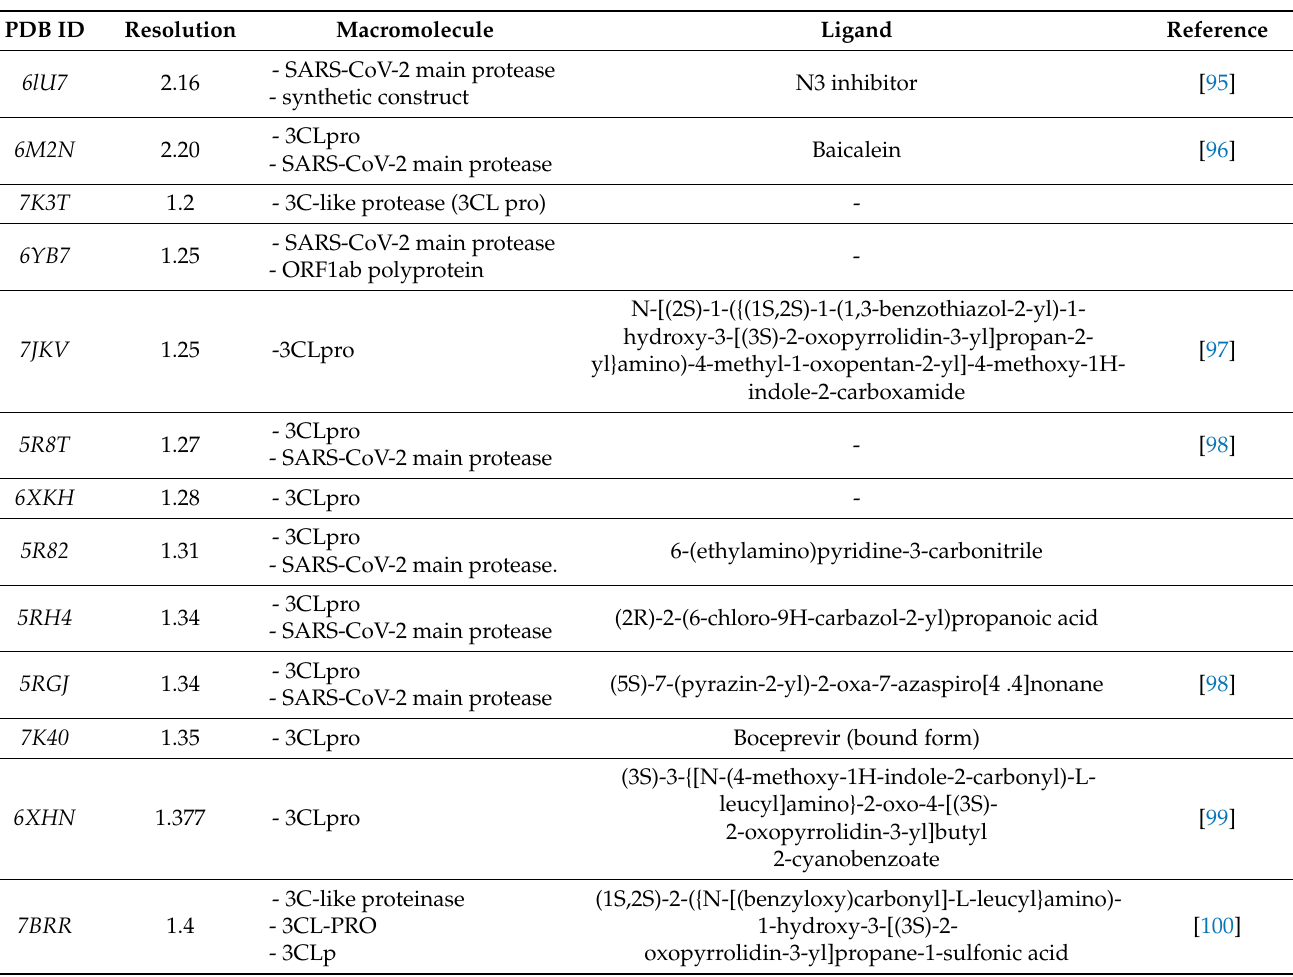
Table 1. The known 3D structures of main protease available on protein data bank